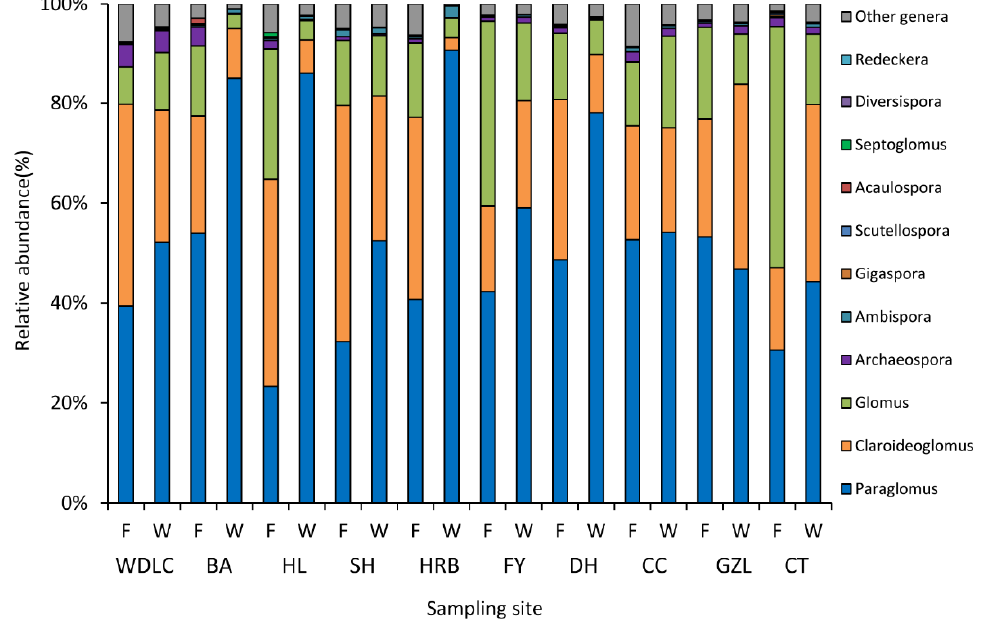
Figure 4. Relative abundance of the arbuscular mycorrhizal fungi genera at the 20 farmland or woodland sampling sites woodland sampling sites (WDLC, Wudalianchi; BA, Beian; HL, Hailun; SH, Suihua; HRB, Harbin; (WDLC, Wudalianchi; BA, Beian; HL, Hailun; SH, Suihua; HRB, Harbin; FY, Fuyu; DH, Dehui; CC, Changchun; GZL, FY, Fuyu; DH, Dehui; CC, Changchun; GZL, Gongzhuling; and CT, Changtu). F and W represent Gongzhuling; and CT, Changtu). F and W represent farmland and woodland respectively. farmland and woodland